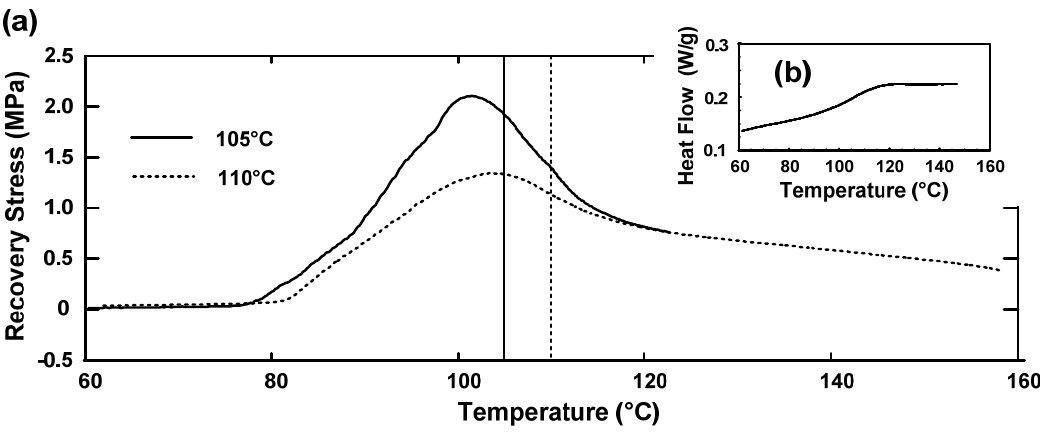
Figure 31. Evolution of recovery stress in PMMA upon heating. ( a ) Recovery stress versus heating temperature curve; and ( b ) DSC curve during heating (heating rate: 10 °C/min). Samples were pre-stretched to a maximum strain of 100% at a strain rate of 0.001 s − 1 at 105 and 110 °C, respectively. (Modified from